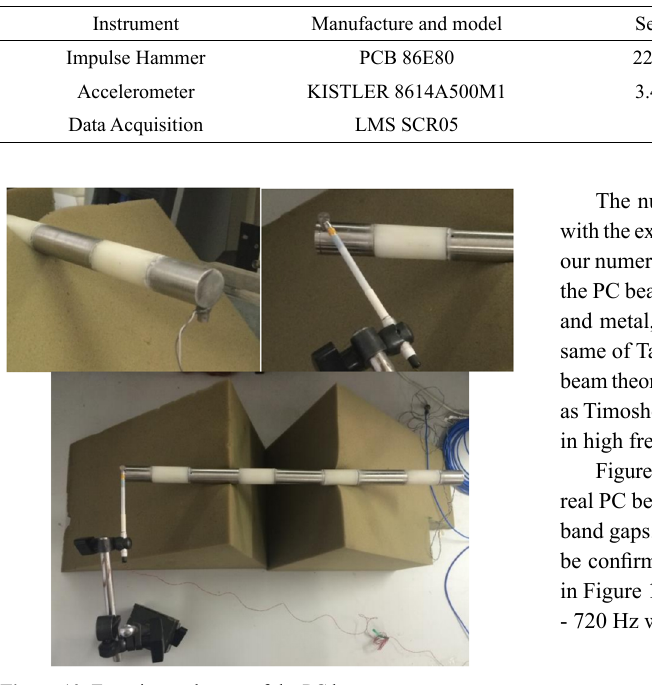
Figure 10. Experimental setup of the PC beam.